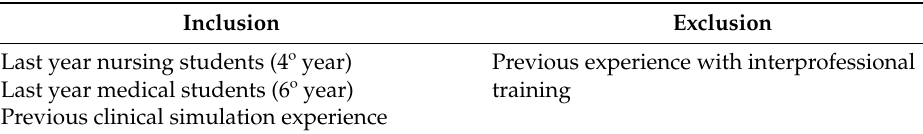
Table 1. Inclusion/Exclusion